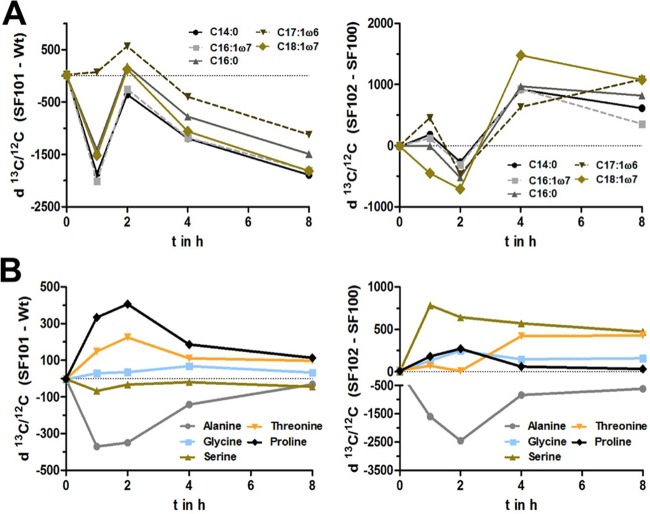
Differential turnover of fatty and amino acids in Wt and ΔaroA variants. (A) 13C incorporation into fatty acids. Salmonella bacteria were fed with labeled glucose, and the 13C/12C ratios of the fatty acids were measured. The values of the parental strain were subtracted from those of the aroA variants. Positive values indicate that the metabolic turnover from 13C-labeled glucose to fatty acid was significantly higher than that for the parental strain. (B) 13C incorporation into amino acids. Left, difference of SF101 (ΔaroA) from Wt. Right, difference of SF102 (ΔlpxR9 ΔpagL7 ΔpagP8 ΔaroA) from SF100 (ΔlpxR9 ΔpagL7 ΔpagP8). The means with standard deviations are displayed. Results are representative for two independent experiments with 3 biological replicates per group.